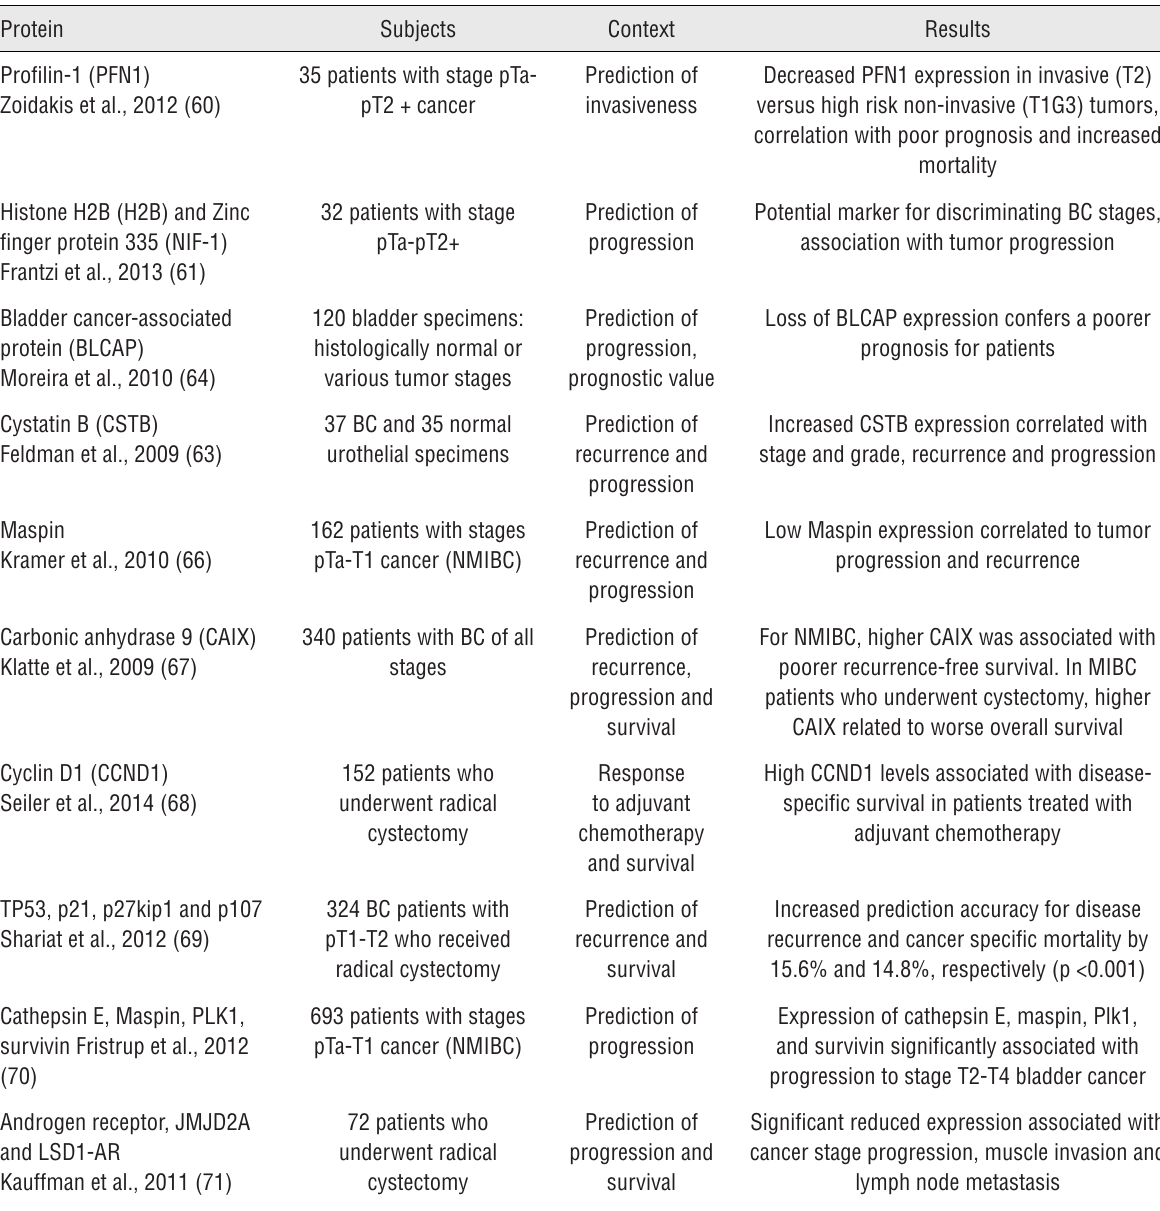
Table 2 - Potential tissue protein biomarkers in Bladder